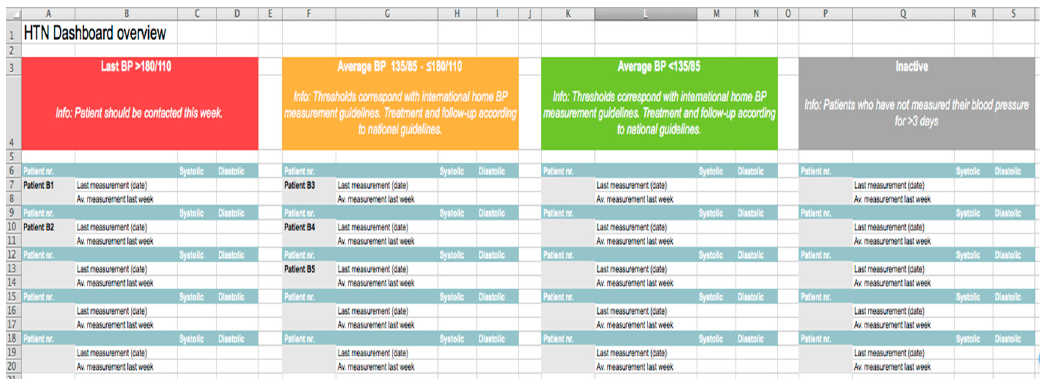
Figure 1. Overview of the dashboard.